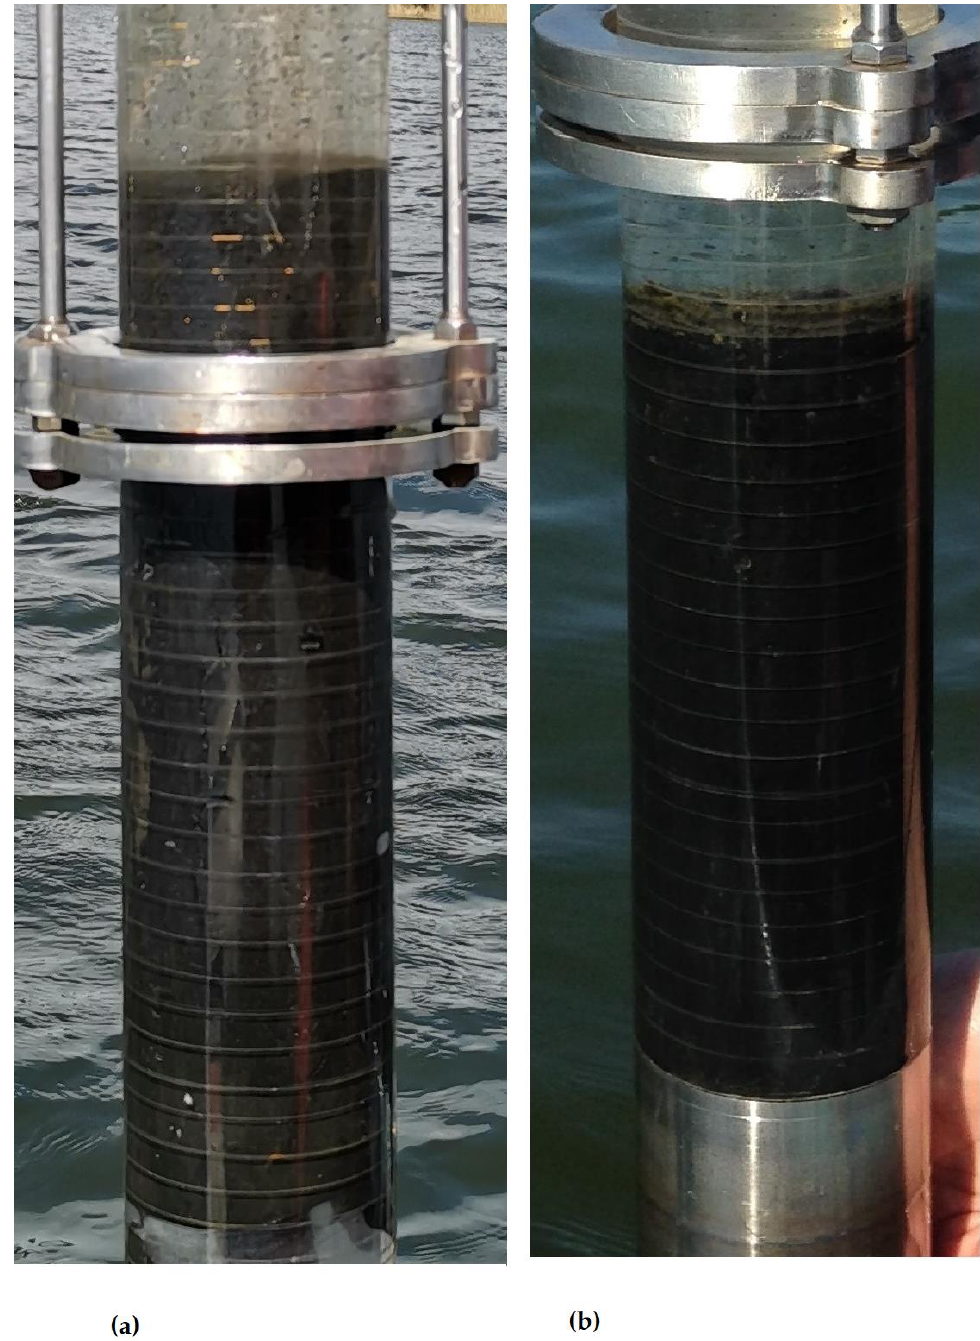
Figure 1. Examples of sediment cores taken at St. 1 ( a ) and St 2. ( b ) (pics by R. Augustyniak-Tunow- ska).